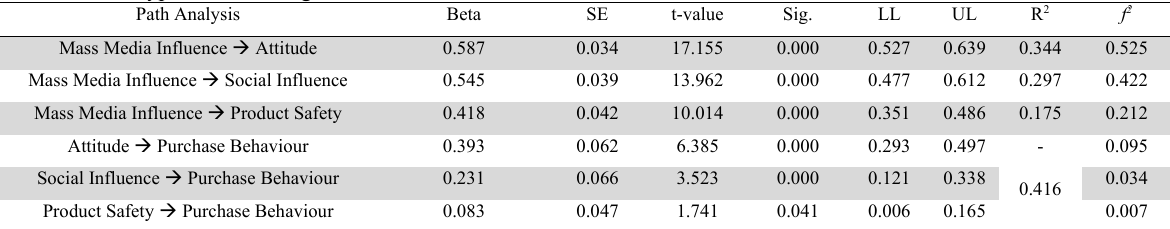
The Result of Hypothesis Testing Path Analysis